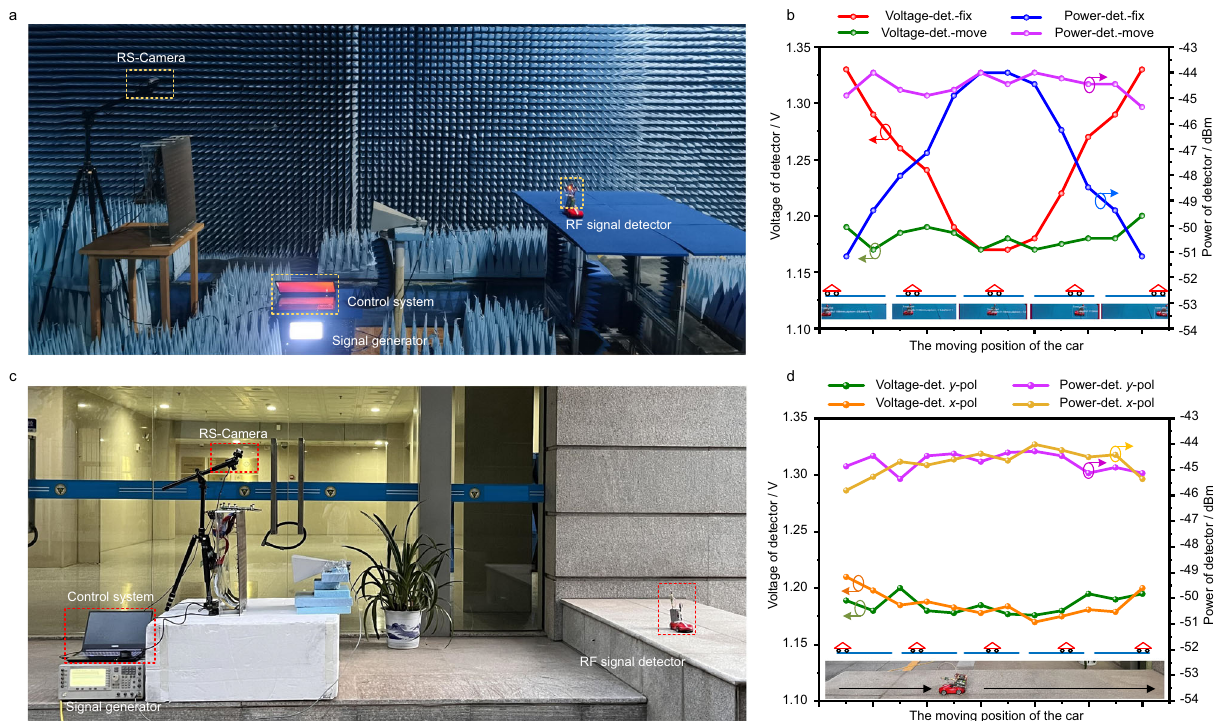
Fig. 6 | Experiments of radio-frequency (RF) signal detections. a A TE-polarized beamfromafeedingantennaisincidentontheDPM.Thepositionofthemodelcar is fed into the control system, and all bias voltages are instantly calculated and supplied to DPM. The re fl ected waves are detected in real-time by the RF signal detector. b RF signal changes when the detector is fi xed (Voltage-det. - fi x) in the